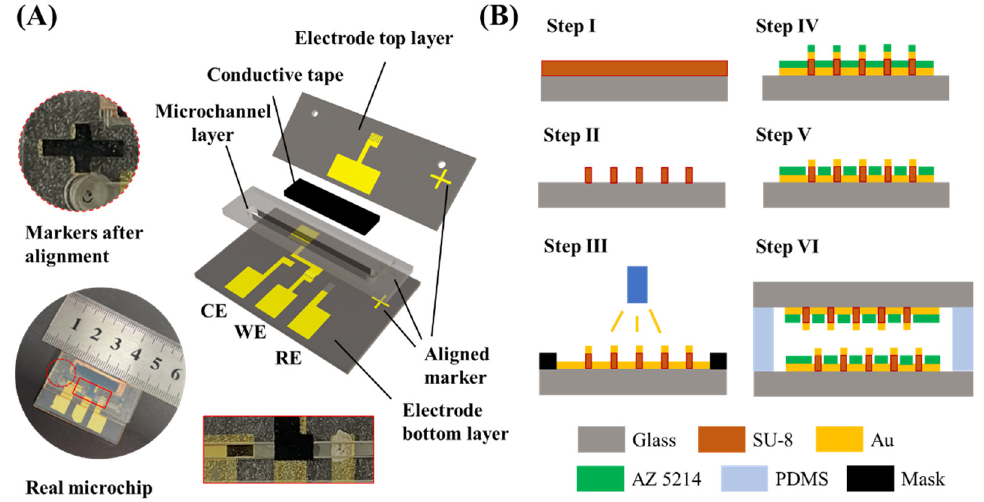
Figure 2. ( A ) The explosion view of the bionic microfluidic chip and the figure of the real chip. ( B ) The fabrication process of the bionic microfluidic chip. ( B ) The fabrication process of the bionic microfluidic